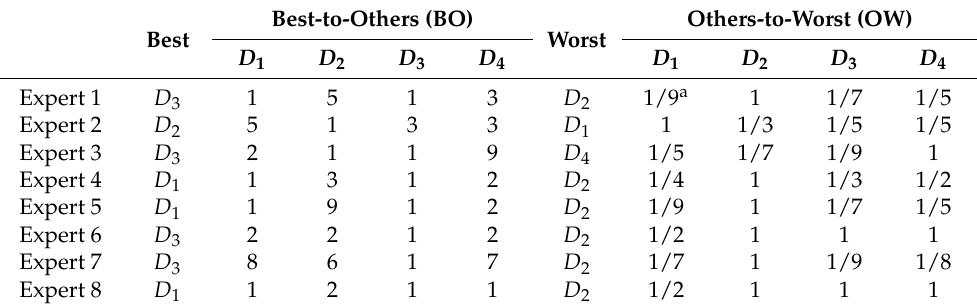
Table 3. Best-to-others (BO) and others-to-worst (OW) vectors of the four dimensions.